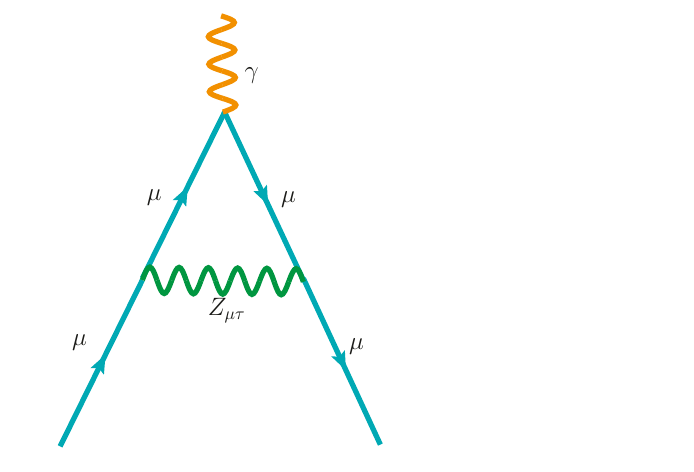
Figure 6 . Feynman diagram for the interaction of new light gauge boson Z (cid:22)(cid:28) with muons. Figure 5(b): contribution due to CP-odd scalar, (cid:30) 0